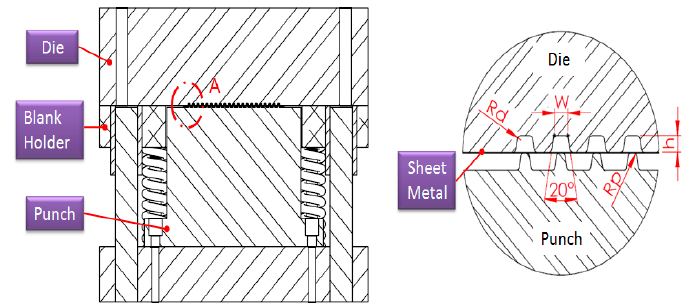
Figure 1. Micro-channel array forming process for stainless steel plates. Table 1. Dimensions of tools.